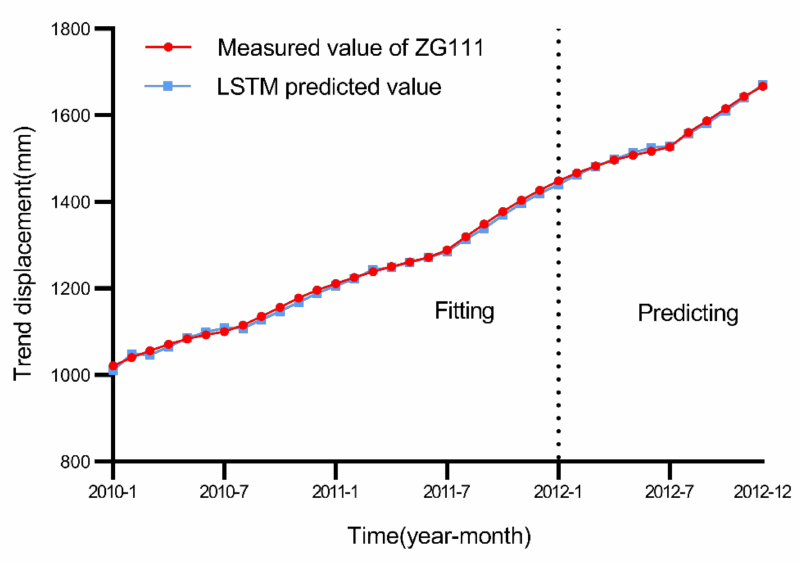
Figure 12. Fitting and predicting results of trend displacement of ZG1113.4. Periodic displacement prediction.